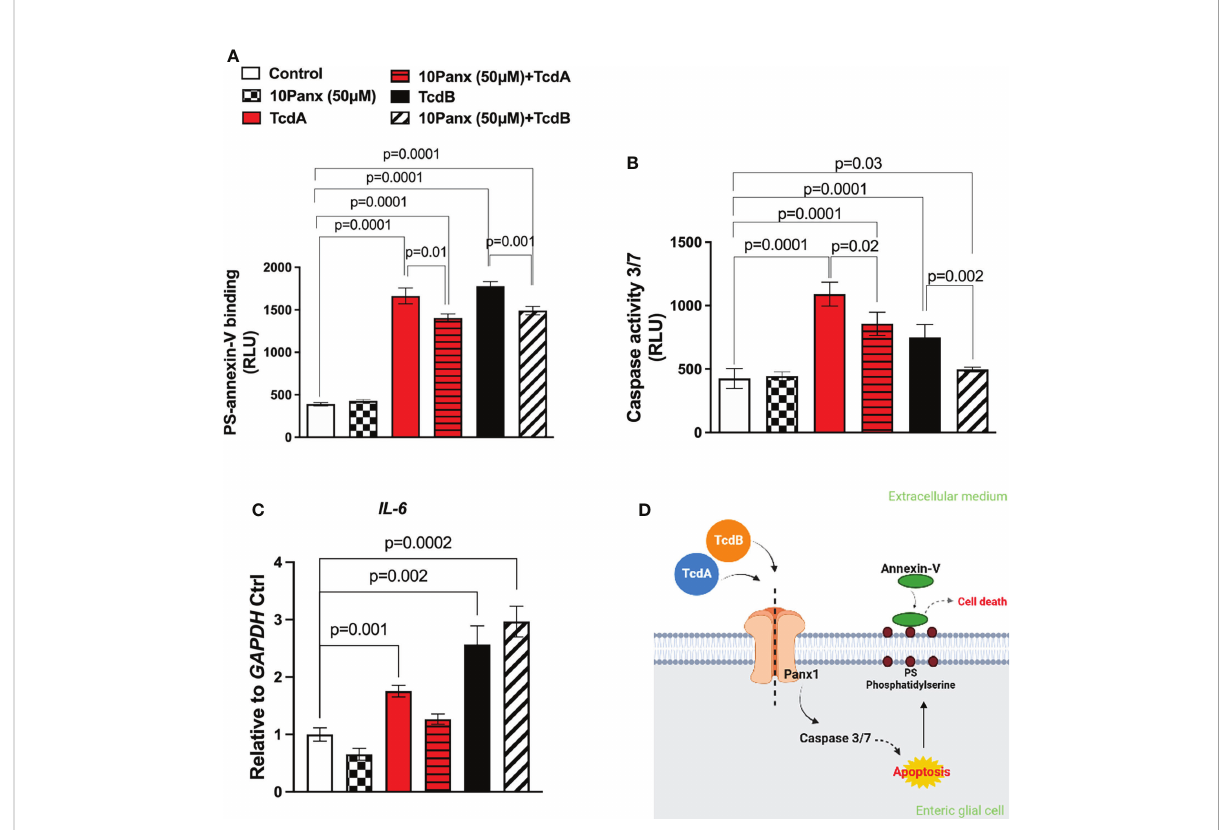
FIGURE 3 Panx1 inhibitor on caspase 3/7 activity and annexin V phosphatidylserine binding in EGCs challenged by TcdA and TcdB in vitro . (A) Cell death was analyzed by RealTime-Glo annexin V apoptosis assay in EGCs incubated for 18 h with TcdA, TcdB and 10Panx tri fl uoroacetate (10Panx; 50µM), a Panx1 antagonist, one hour prior to toxin challenge. For statistical analysis, the one-way ANOVA test was used followed by the Tukey test; the p value is represented in the graph. (B) The activity of caspase 3/7 was analyzed by luminescence assay in EGCs incubated for 18 h with TcdA, TcdB and 10Panx (50µM), one hour prior to toxin challenge. (C) IL-6 gene expression was evaluated by qPCR in EGCs challenged by TcdA and TcdB for 18h, previously incubated or not with Panx1 inhibitor (10Panx, 50 m M). The data are the mean ± SEM. For statistical analysis, the one-way ANOVA test was used followed by the Tukey test; the p value is represented in the graph. (D) Proposed model of the role of Panx1 signaling in TcdA and TcdB-induced cell death in EGCs. TcdA and TcdB activate Panx1 in EGCs. Its activation results in the activation of